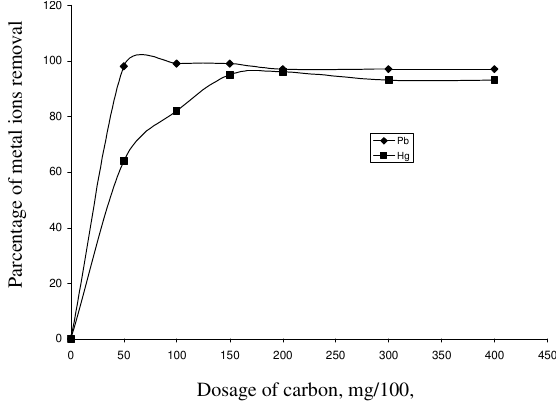
Figure 5 . Effect of carbon dosage (1:3) for Pb:Hg solution.